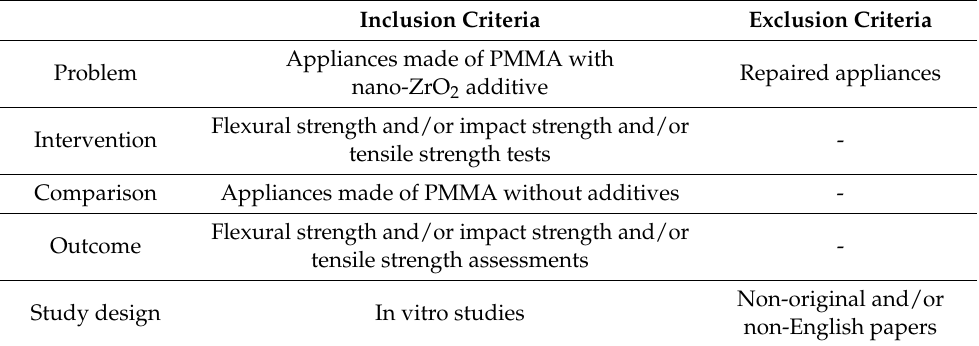
Repaired appliances - - Non-original